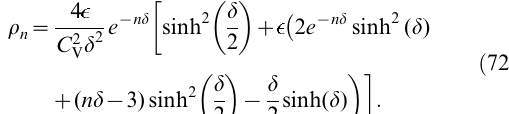
Figure 14. Illustration of the deterministic dynamics of the adaptive PIF neuron. The flow in the phase space spanned by ( V , a ) possesses a stable limit cycle, which consists of the voltage drift from V reset at a ~ a (cid:2) to the threshold (A), the following increase of a by an amount D (B) and the subsequent voltage reset (C). The period of the limit cycle ^ TT (cid:2) is solely due to the time of the process A, whereas the processes B and C occur instantaneously. A trajectory starting off the limit cycle at ( V reset , a (cid:2) z d a i ) reaches the threshold at the time ^ TT (cid:2) z d ^ TT i . The deviation from a (cid:2) after one period has an absolute